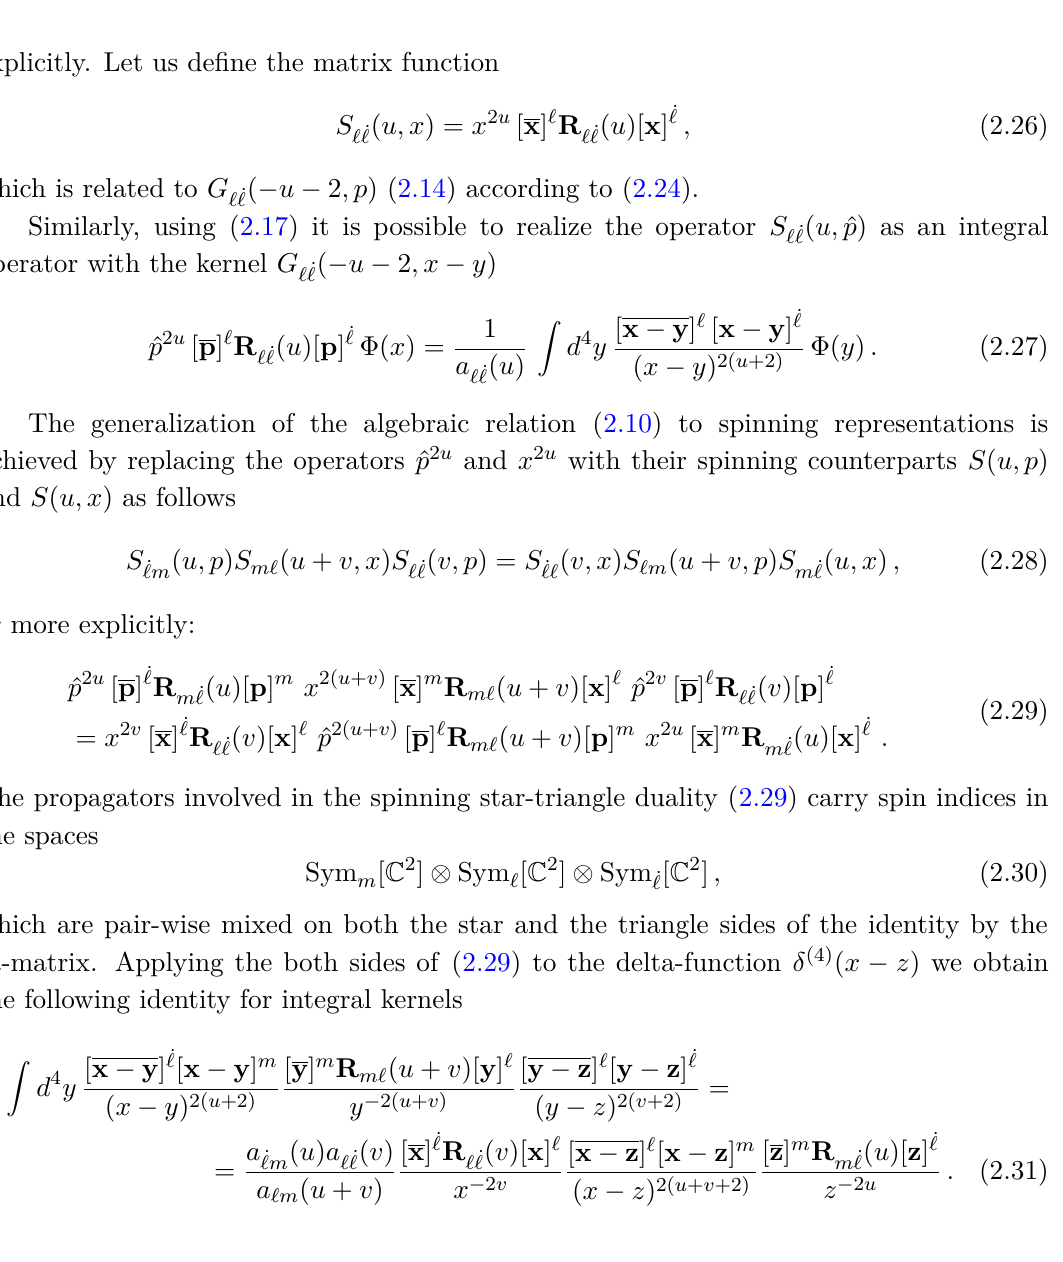
Figure 6 . Up: parity property of the matrix R mn ( u ) . The product of two matrices with opposite arguments along two spinorial structure with the same orientation cancels. Down: crossing symme- try of the matrix R ( u ) . The two matrices act along two spinor structures flowing in the opposite mn directions, according to the arrows, so their product is transposed in one of the two spinor